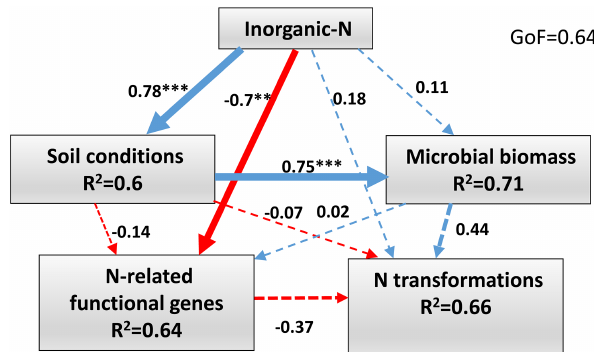
Figure 6. Directed graph of the partial least squares path model (PLS-PM) of the inorganic N (NH + -N and NO − -N), soil conditions 4 3 (pH, SOC, TN, C / N ratio and SWC), microbial biomass (MBC and MBN) and the abundance of functional genes (AOA amoA , AOB amoA , nirK and nosZ ) effects on soil N-transformation rates ( R m , R n , R l and N 2 O emission) in the wet season. Path coefficients and explained variability ( R 2 ) reflected in the width of the arrow were calculated after 1000 bootstraps. Blue and red arrows repre- sent positive and negative effects, respectively. Solid arrows indi- cate P < 0 . 05 and dashed arrows indicate P > 0 . 05. The model was assessed using the goodness of fit (GoF). Significance levels are indicated by ∗ P < 0 . 05, ∗∗ P < 0 . 01 and ∗∗∗ P < 0 .